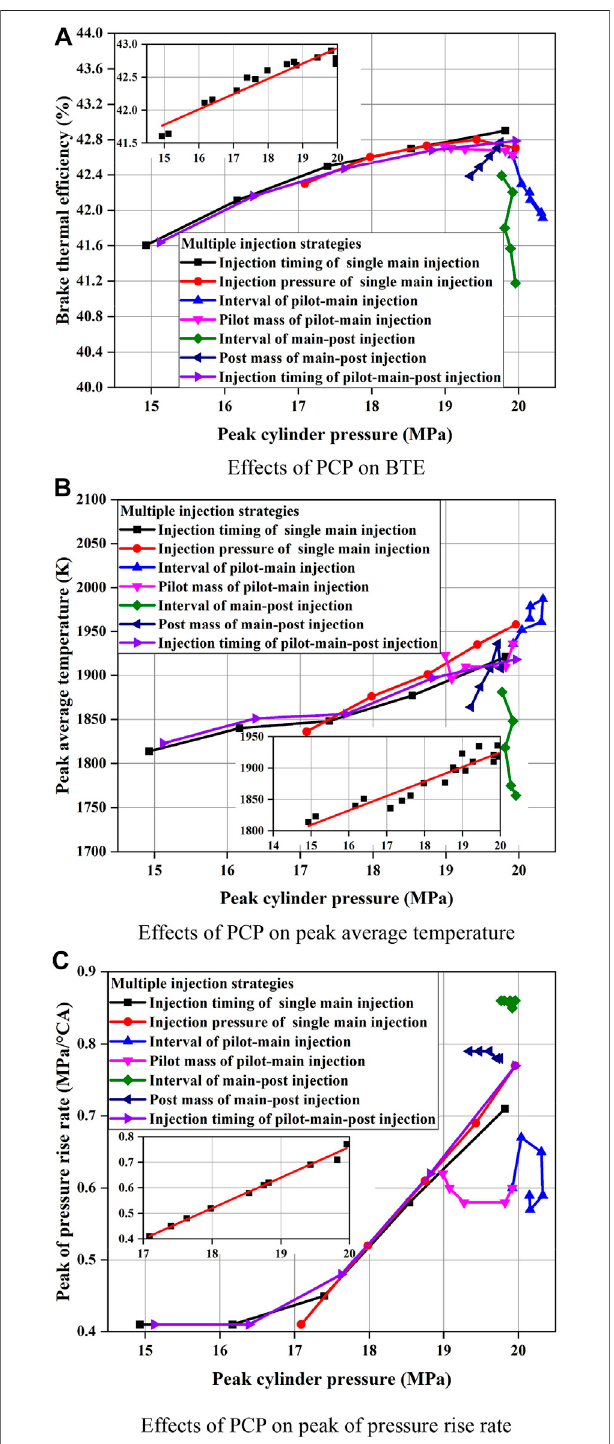
FIGURE12| EffectsofPCPonperformance. (A) EffectsofPCPonBTE, (B) Effects of PCP on peak average temperature, (C) Effects of PCP on peak of pressure rise